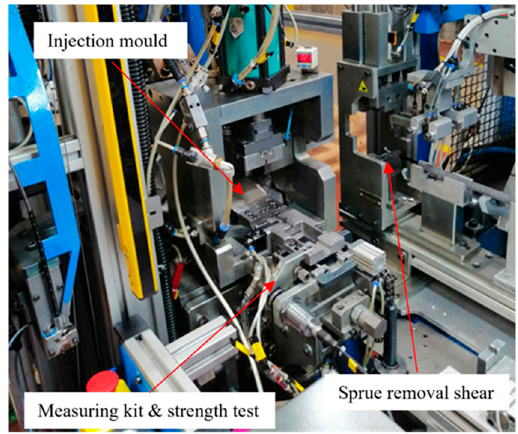
Figure 22. Equipment after assembly and ready for operation.